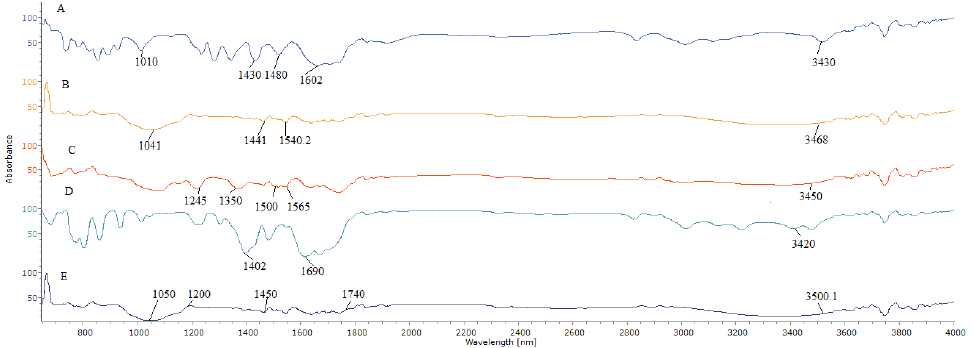
Figure 1. ATR-FTIR spectra of ( A ) ALG, ( B ) GA, ( C ) Free curcumin, ( D ) ALG-GA nanoparticles, ( E ) Cur/ALG-GANPs.